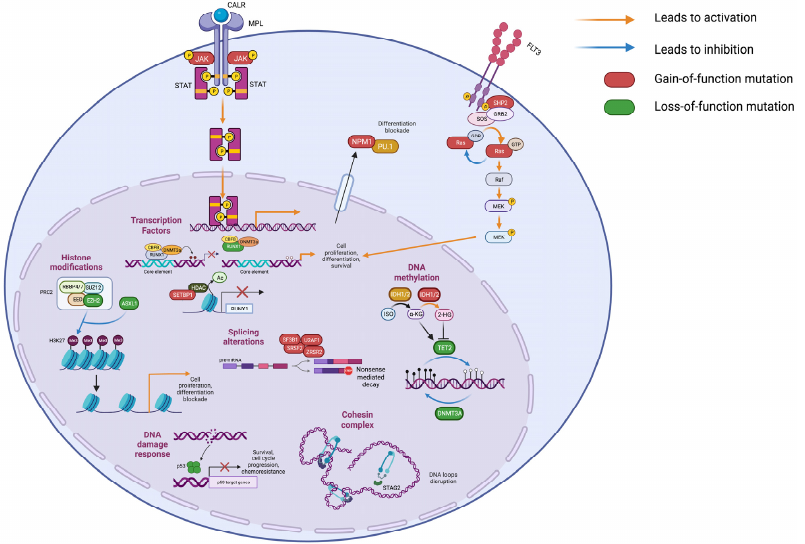
Figure 3. Molecular events responsible to MPN onset and evolution. This image summarizes the molecular processes and pathways involved in MPN onset and leukemic evolution described in the